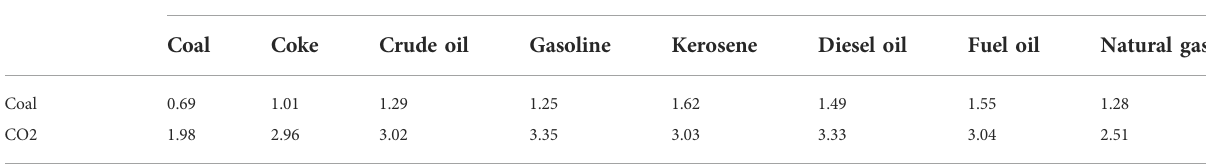
TABLE 3 Different energy sources and their coef fi cients for carbon